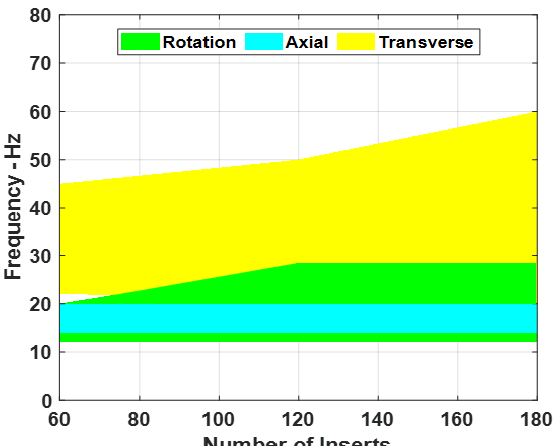
Figure 14. Effect of number of periodic inserts with LR on the spectral width of the stop bands of a passive periodic drill-string for the rotation, axial, and transverse vibrations.